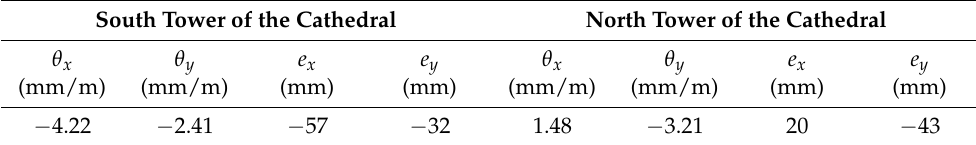
Table 2. Calculated inclination of the towers θ x and θ y